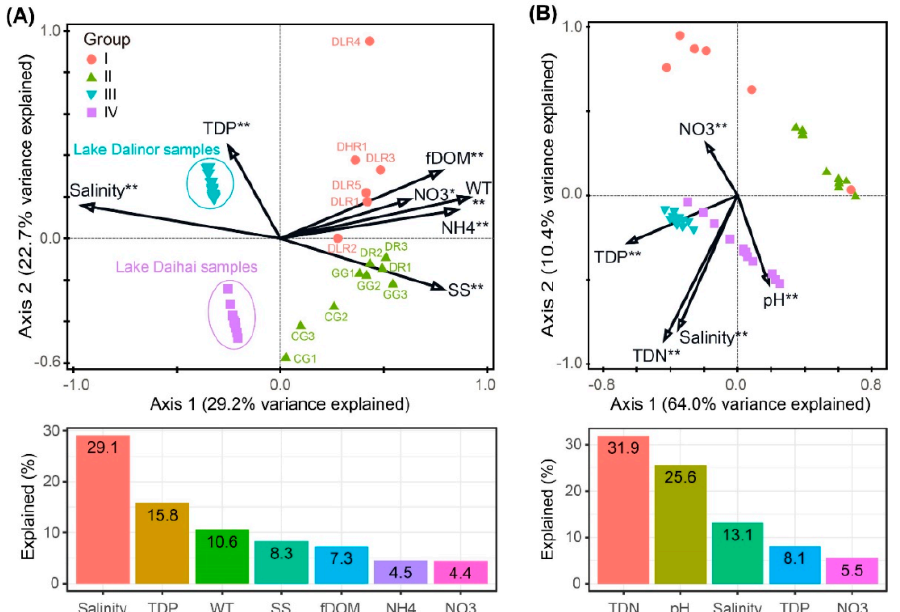
Figure 5. Redundancy analyses (RDA) ordination plots showing the significant environmental factors in structuring variations in ( A ) bacterial community composition, and ( B ) predicted bacterial functional composition. Bar plots are presented below each RDA plot panel, showing the variation explained by each factor. Significance levels: * corrected p -value < 0.05, ** corrected p -value < 0.01. TDP, total dissolved phosphorus; WT, water temperature; SS, suspended solids; fDOM, fluorescent dissolved organic matter; NH4, ammonia nitrogen; NO3, nitrate; TDN, total dissolved